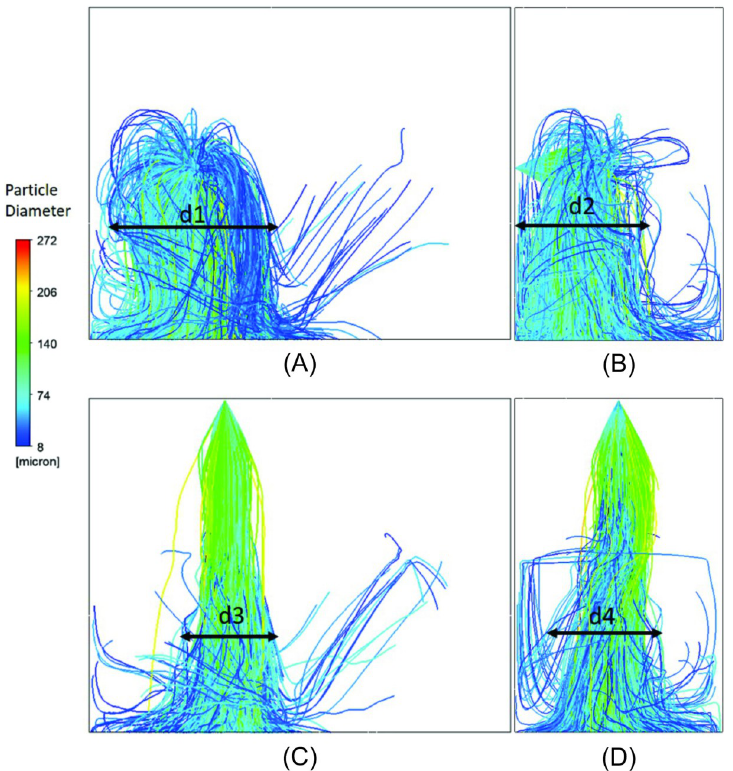
Fig 16. Contours of the nozzles N1 and N2. (A) Front view and (B) Side view of the horizontal nozzle (N1); (C) Front view and (D) Side view of the vertical nozzle (N2).